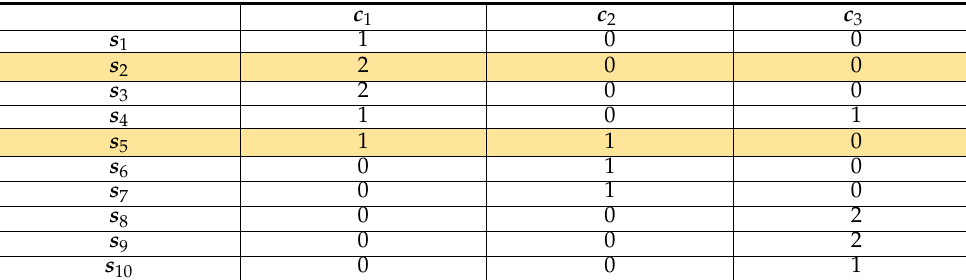
Table 3. The symptoms community matrix (SCM) derived from the toy problem KG. The evidence symptoms are highlighted for the future calculation of the LinD for each community.